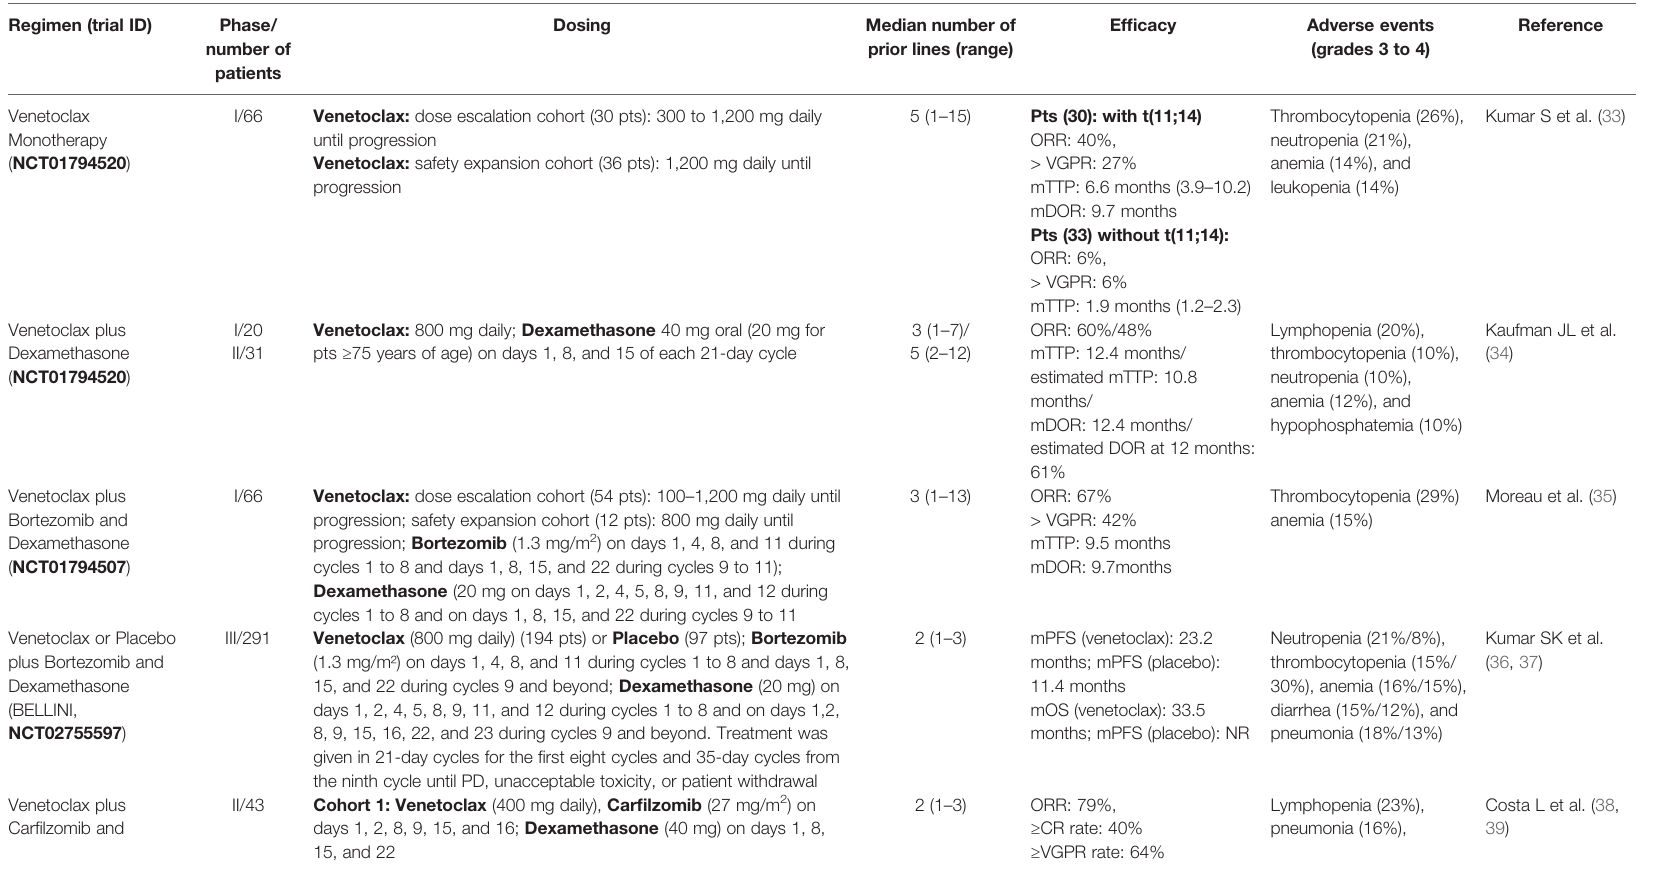
TABLE 2 | Summary of fi ndings of main clinical trials with venetoclax in relapsed/refractory multiple myeloma